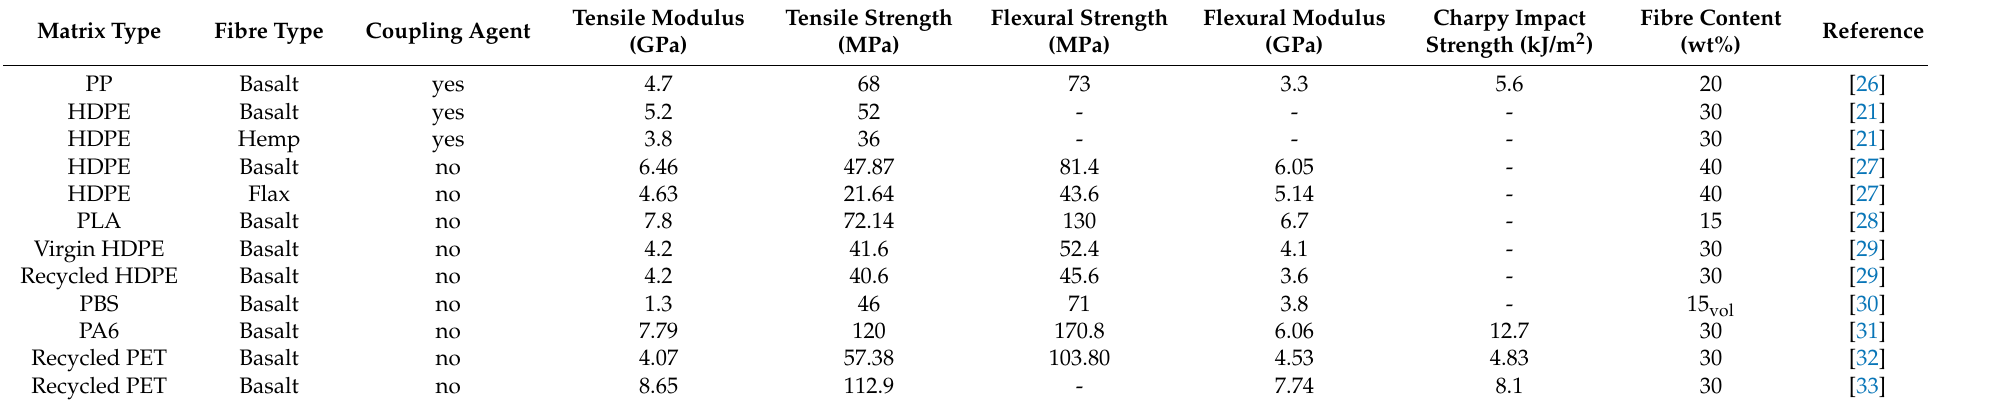
Table 5. Summary of mechanical properties of polymer matrix composites reinforced with basalt and plant